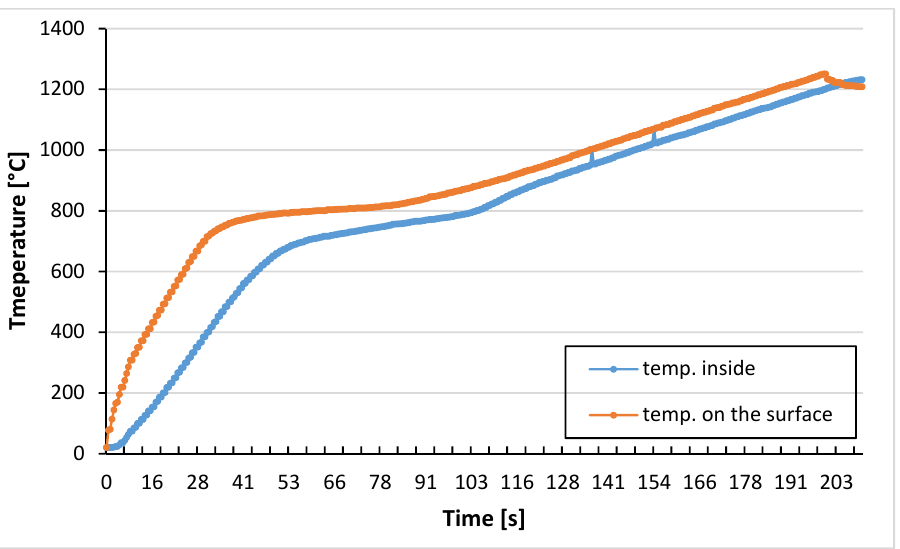
Time [s] Figure 1. The temperature of rod during the process of induction heating. Figure 1. The temperature of rod during the process of induction